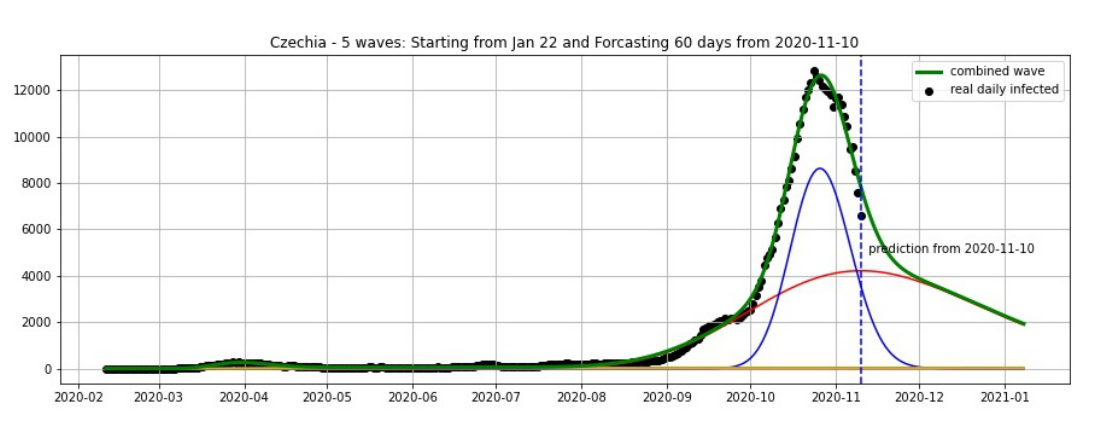
Figure 15. Czechia: fitting and forecasting from 10 November with 5 wavelets. The green curve is the combination of other curves which are EF wavelets.